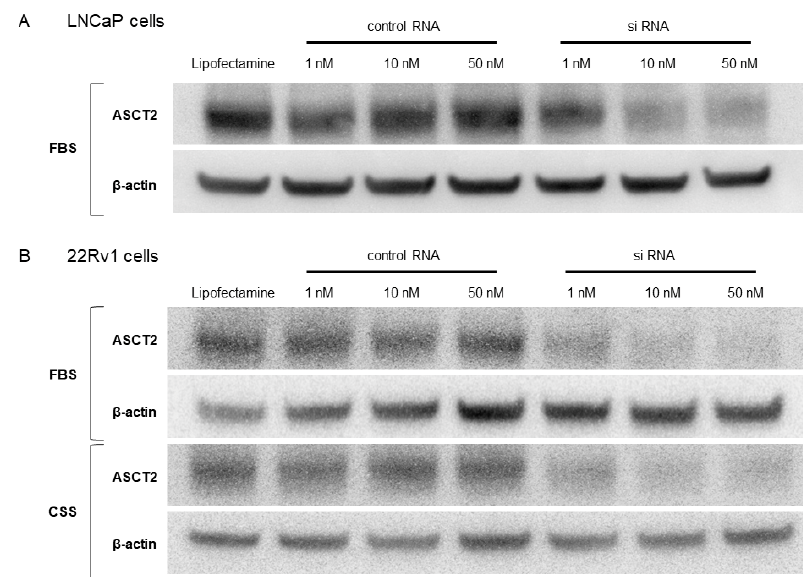
Figure 2. Knockdown of ASCT2 with siRNA transfection in LNCaP ( A ) and 22Rv1 ( B ) cells.